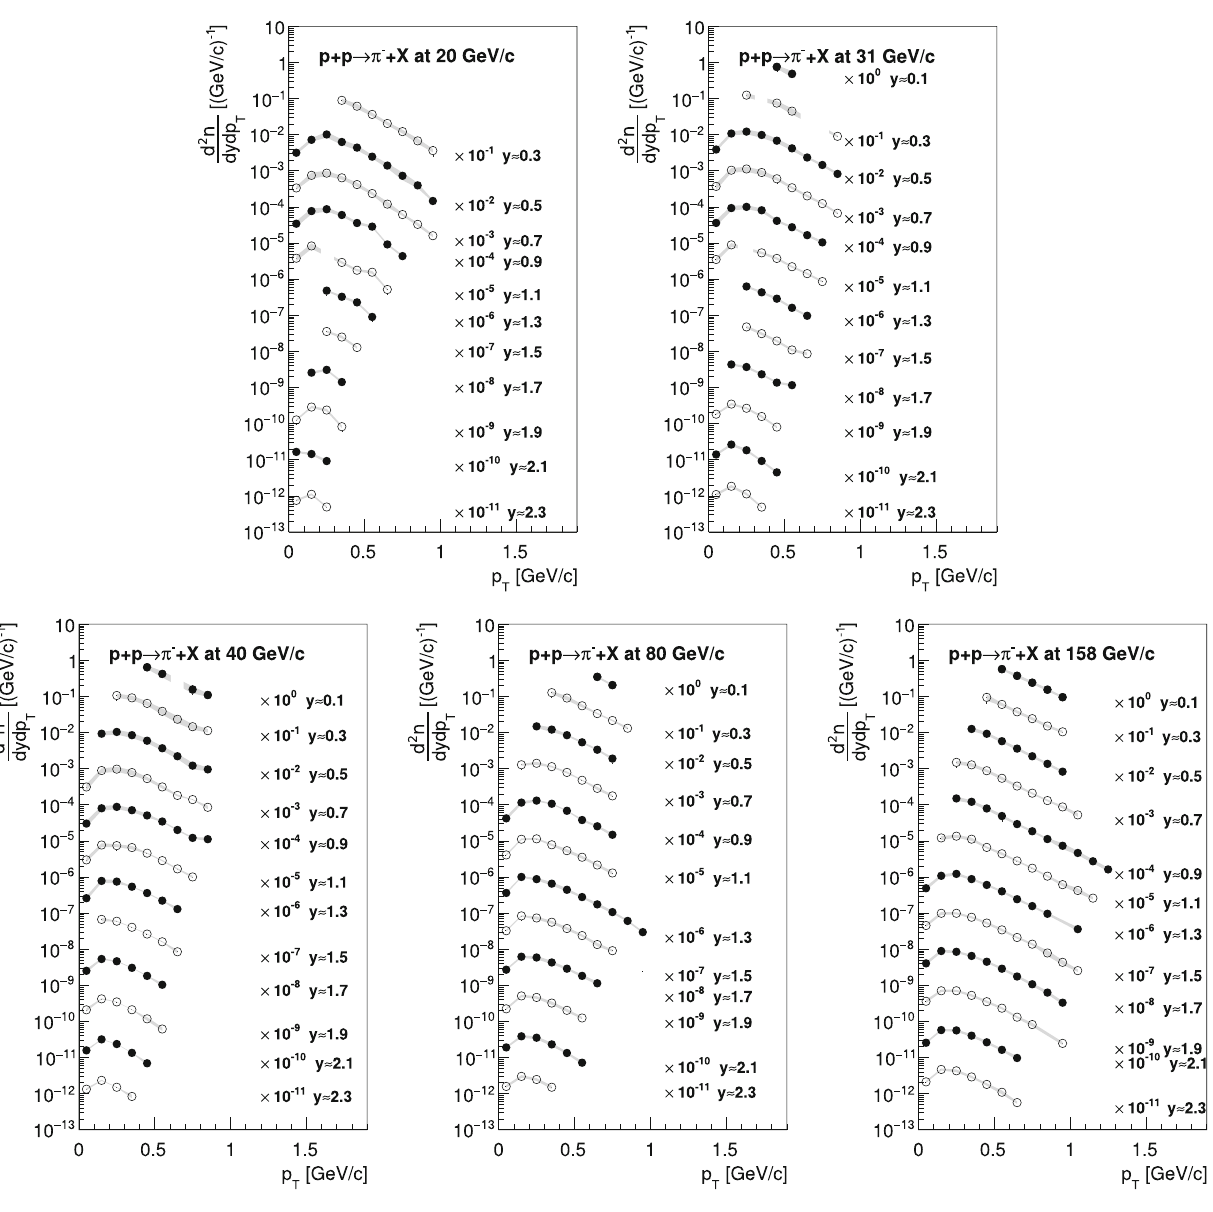
Fig. 28 Transverse momentum π − spectra in rapidity slices produced in inelastic p + p interactions at 20, 31, 40, 80, 158 GeV / c . Rapidity values given in the legends correspond to the middle of the corresponding interval. Shaded bands show systematic uncertainties